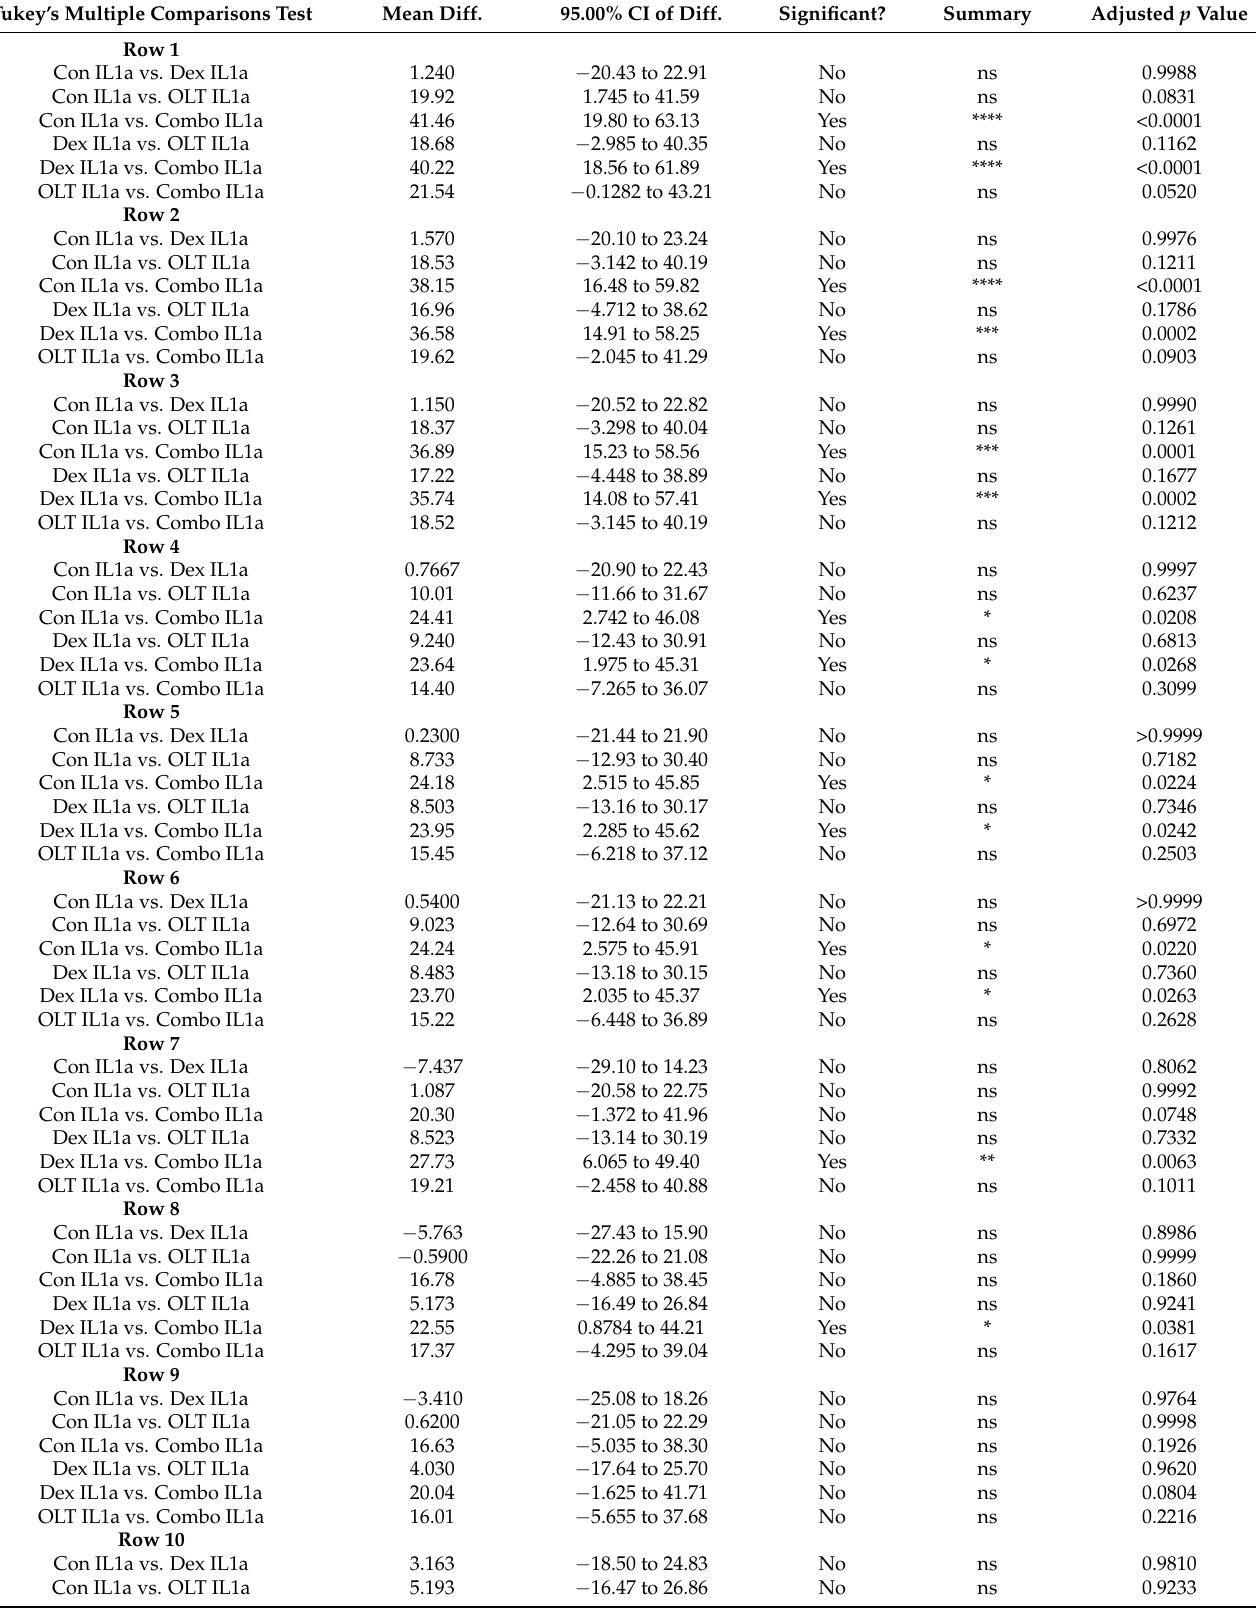
Table 2. Statistical analysis of Figure